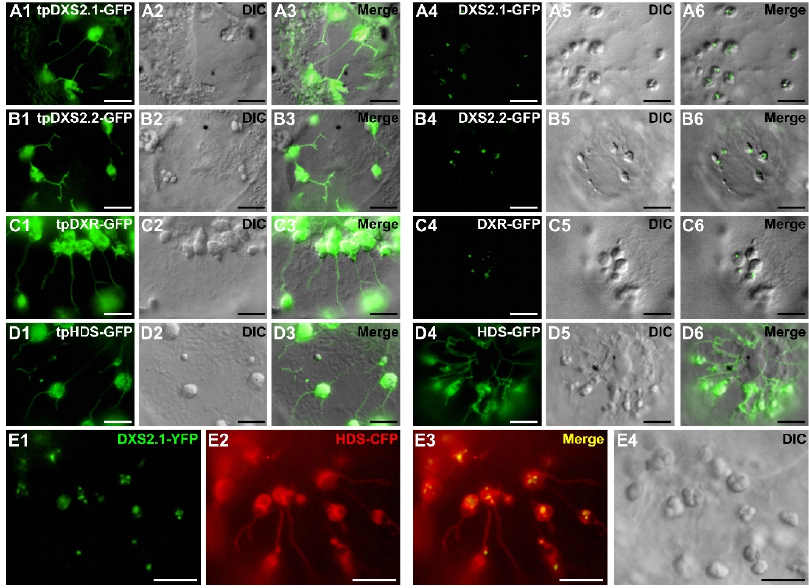
Figure 7. Comparison of the subcellular localization of DXS2.1, DXS2.2, DXR and HDS expressed as full-length-GFP fusion proteins or as transit peptide-GFP fusion proteins. C. roseus cells were transiently transformed with plasmids expressing a GFP protein fused to the first 100 residues of the enzyme, encompassing the predicted transit peptide (tp) of DXS2.1 (tpDXS2.1-GFP, A1-A3 ), DXS2.2 (tpDXS2.2-GFP, B1-B3 ), DXR (tpDXR-GFP, C1-C3 ), HDS (tpHDS-GFP, D1-D3 ), or fused to full-length DXS2.1 (DXS2.1-GFP, A4-A6 ), DXS2.2 (DXS2.2-GFP, B4-B6 ), DXR (DXR-GFP, C4-C6 ), HDS (HDS-GFP, D4-D6 ). An additional co-transformation of DXS2.1-YFP ( E1 ) and HDS-CFP ( E2 ) was performed to highlight differences of localization in plastids as revealed on the merged image ( E3 ). Cell morphology was observed with differential interference contrast (DIC, E4 ). Bar: 10 µ m.